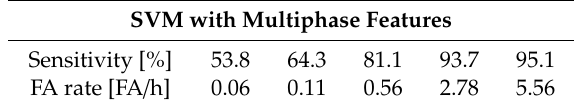
Table 3. Additional combinations of sensitivity and false alarm